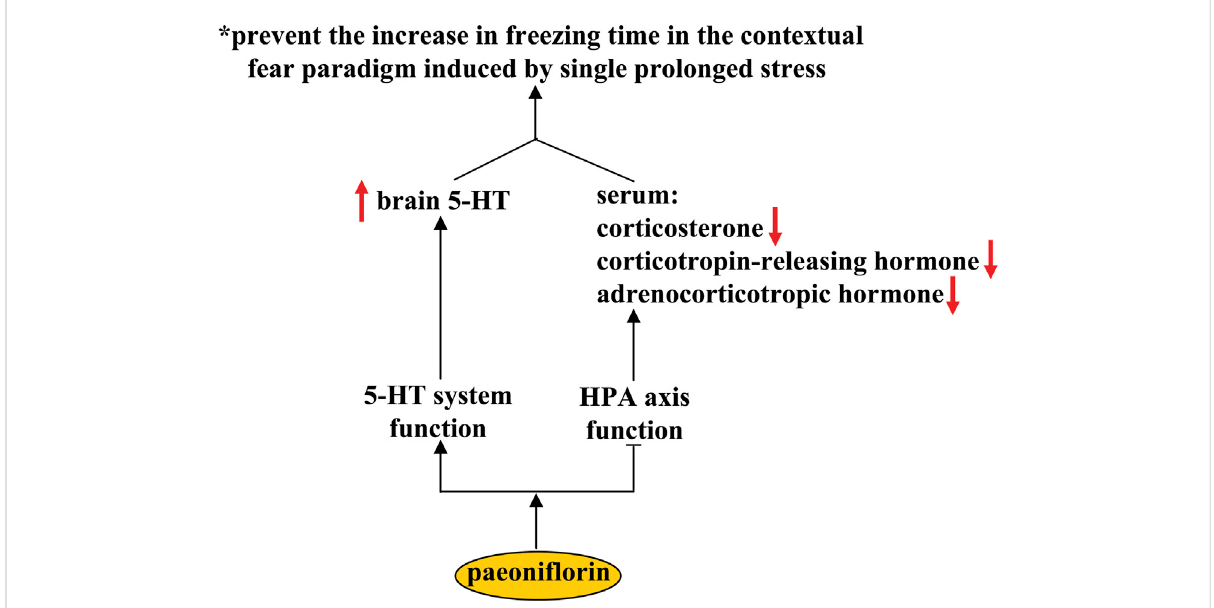
Effects and mechanisms of paeoni fl orin in post-traumatic syndrome disorder. Paeoni fl orin administration can prevent the increase in freezing time in the contextual fear paradigm induced by single prolonged stress by increasing brain concentrations of 5-HT and decreasing serum concentrations of corticosterone, corticotropin-releasing hormone, and adrenocorticotropic hormone. However, it isstill unclear how paeoni fl orin improve the function of the 5-HT system and how paeoni fl orin suppresses the functions of the HPA